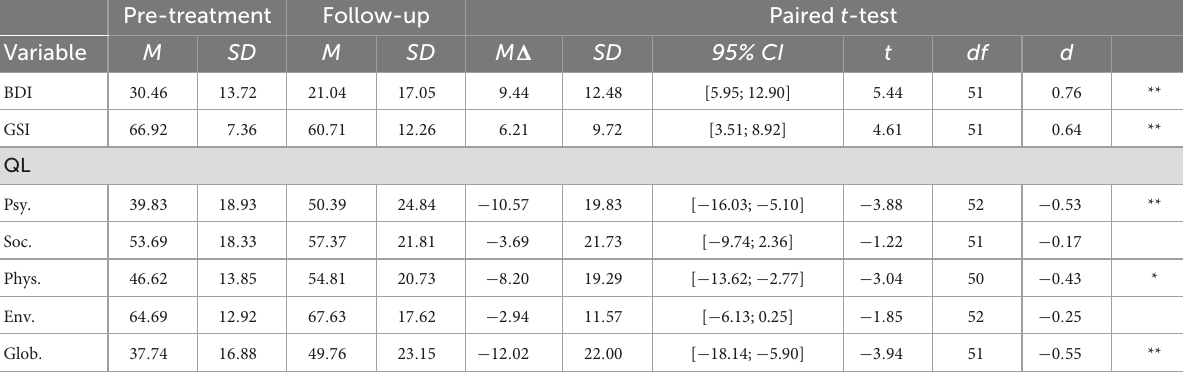
CI,confidenceinterval.HighervaluesinBDIandGSIrepresenthighersymptomseverity.HighervaluesinQLrepresenthighersubjectivequalityoflife.* p < 0.007(Bonferroni-corrected), ** p <